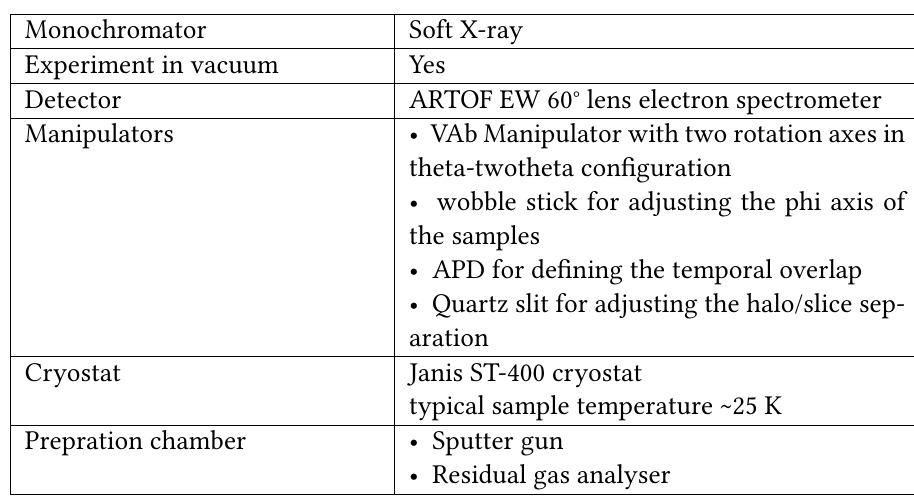
Table 1: Technical parameters of the FEMTOSPEX Molecules and Surfaces